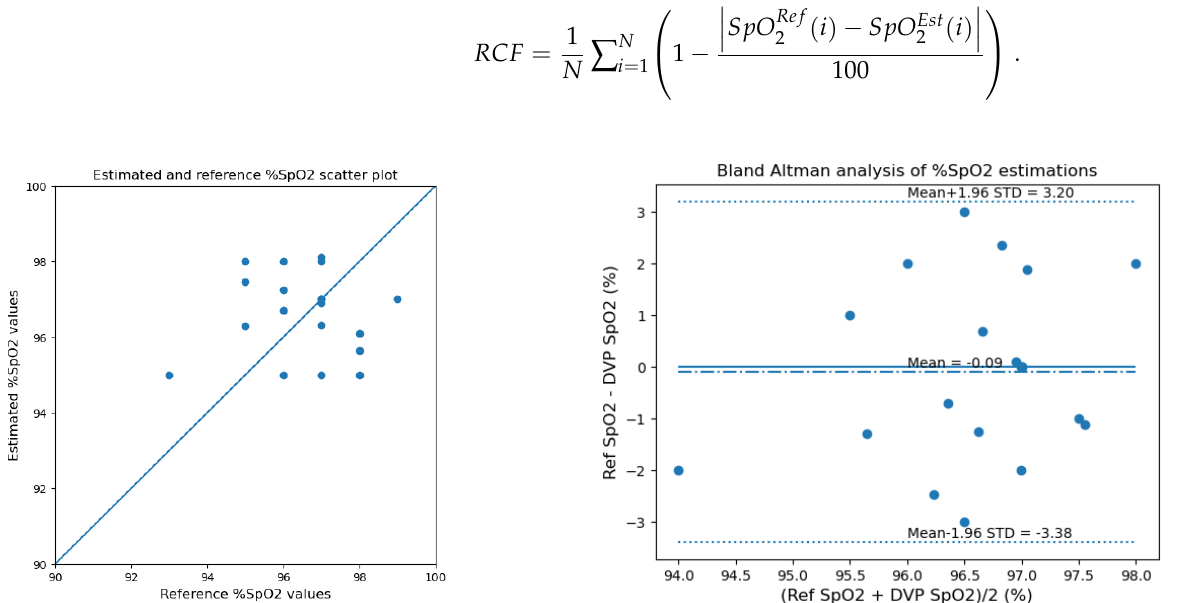
Figure 8. Scatter plot and Bland–Altman analysis for the estimated SpO (cid:2870) values after ratio calibra- tion.